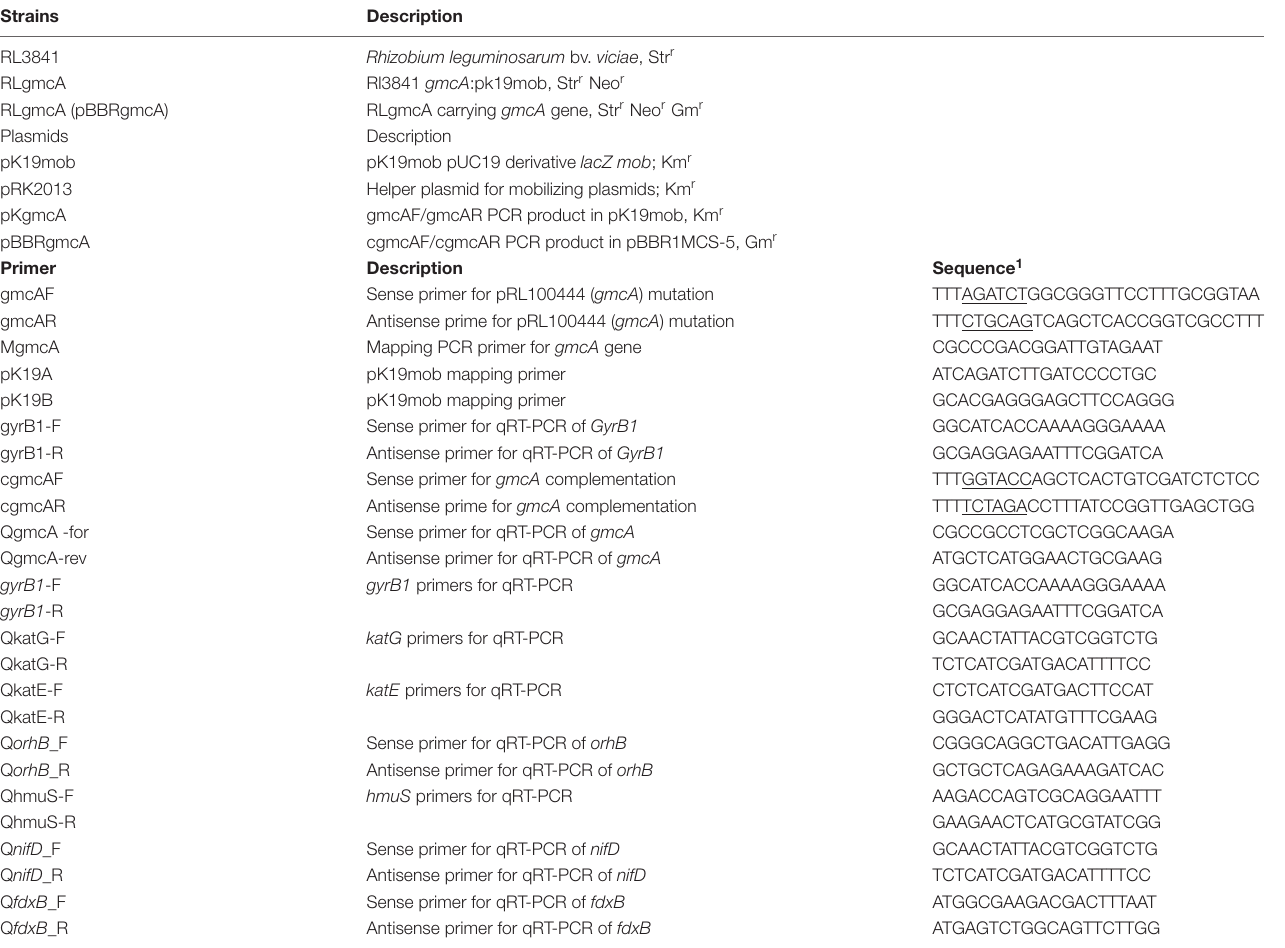
TABLE 1 | Strains, plasmids, and